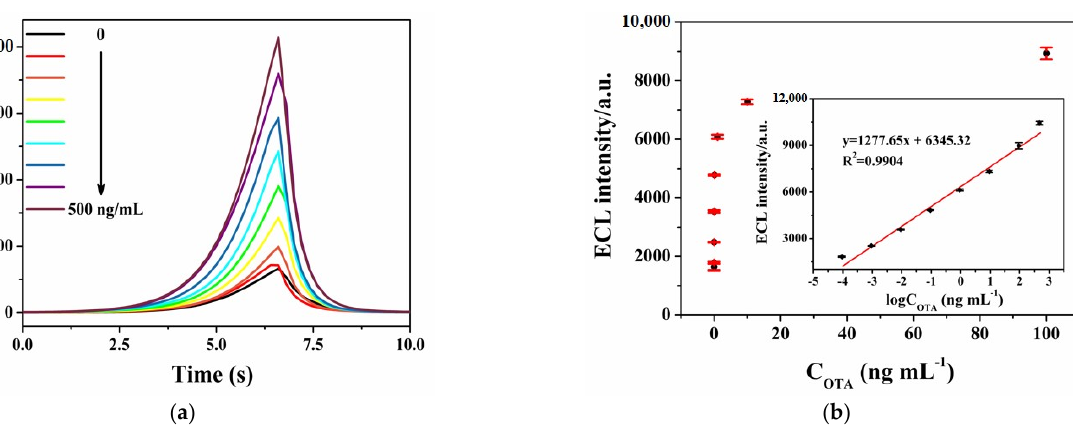
Figure 7. ( a ) ECL response of the ECL − RET immunosensor at different concentrations of OTA from 0.1 pg/mL to 500 ng/mL in 0.1 M PBS containing 20 mM K 2 S 2 O 8 and 0.1 M KCl; ( b ) calibration curve of the ECL − RET immunosensor for OTA detection. (PMT: 700 V, scan rate: 100 mV/s, magnification: 2). Table 1. Performance comparison with other ECL sensors used for OTA detection. Type of the Electrode